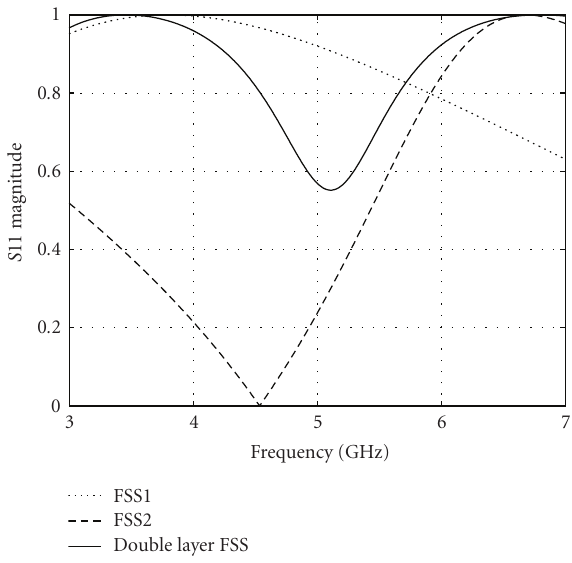
Figure 2: Reflection coe ffi cient